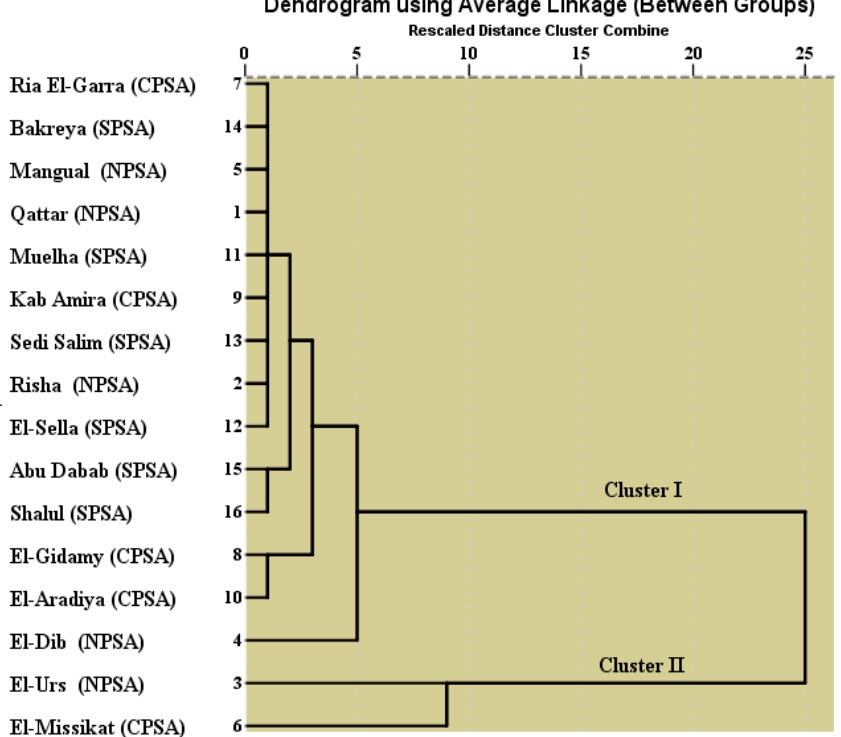
Figure 5. Similarity among the locations of the three parts depending on the radionuclide concentrations in term of cluster analysis.